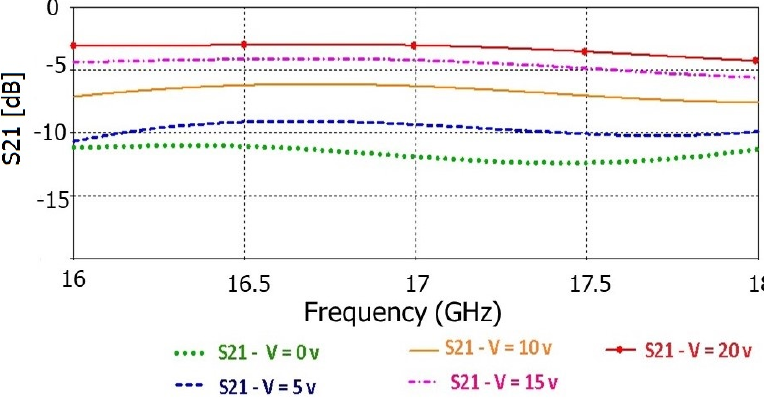
Figure 8. Insertion loss of the SIW variable phase shifter for five different biasing voltages.